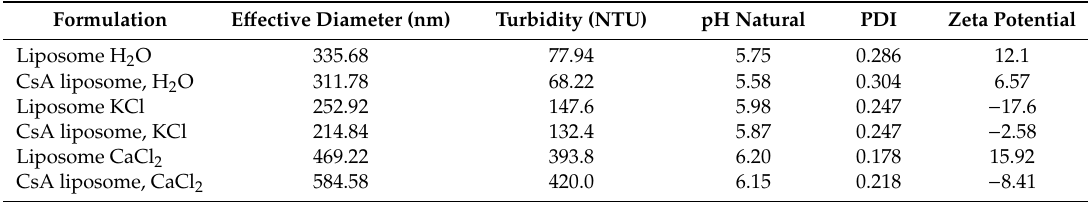
Table 2. Formulation characterization of DPPC and CsA / DPPC liposomes in di ff erent electrolyte solutions (10 − 2